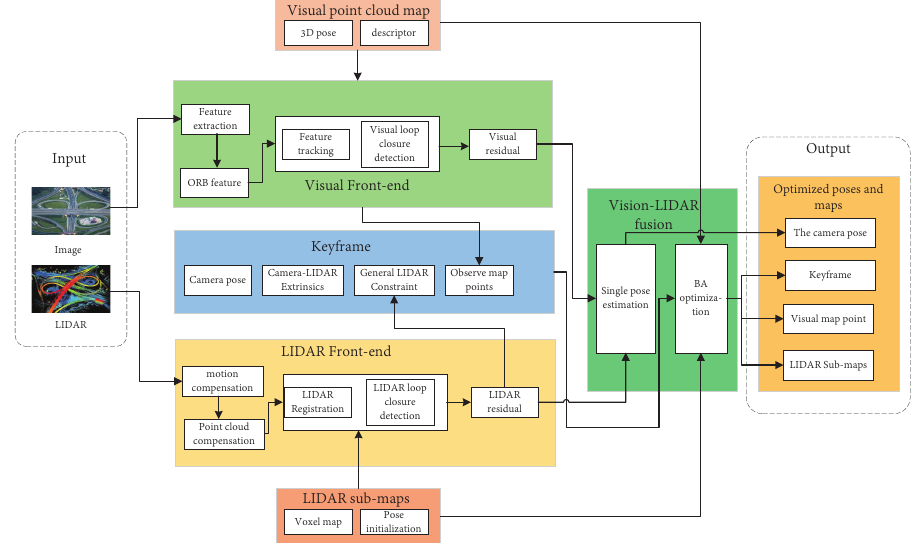
Figure 22. Frame diagram of tightly coupled feature-based visual–LIDAR fusion, in which different colors are used to represent different modules. Reproduced with permission of Ref. [192], Copyright of 2021 IEEE Transactions on Intelligent Transportation Systems